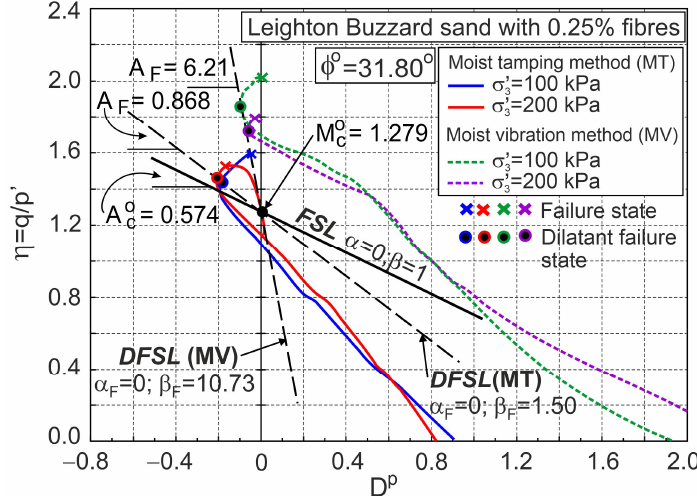
Figure 12. Stress ratio–plastic dilatancy relationships for Leighton Buzzard sand with 0.25% of fibres (based on the experimental data from [34]). (based on the experimental data from